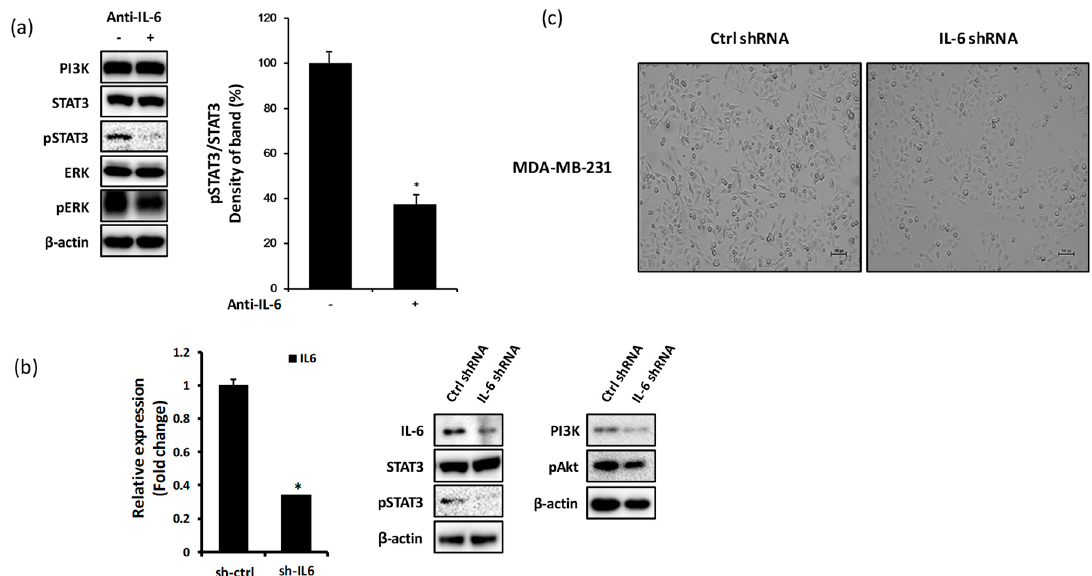
Figure 2. Blockade of IL-6 expression decreases the levels of pSTAT3, PI3K, and pAkt in MDA-MB-231 cells. MDA-MB-231 cells were treated with anti-IL-6 antibody or IL-6 shRNA. After 24 h of incubation, cell lysates were harvested and analyzed by western blotting. ( a ) Expression of PI3K, STAT3 (and pSTAT3), and ERK (and pERK) proteins. ( b ) Expression of IL-6, STAT3 (and pSTAT3), PI3K, and pAkt proteins. ( c ) Morphology of MDA-MB-231 cells (scale value is 100px). Significant difference is shown: * p < 0.05.